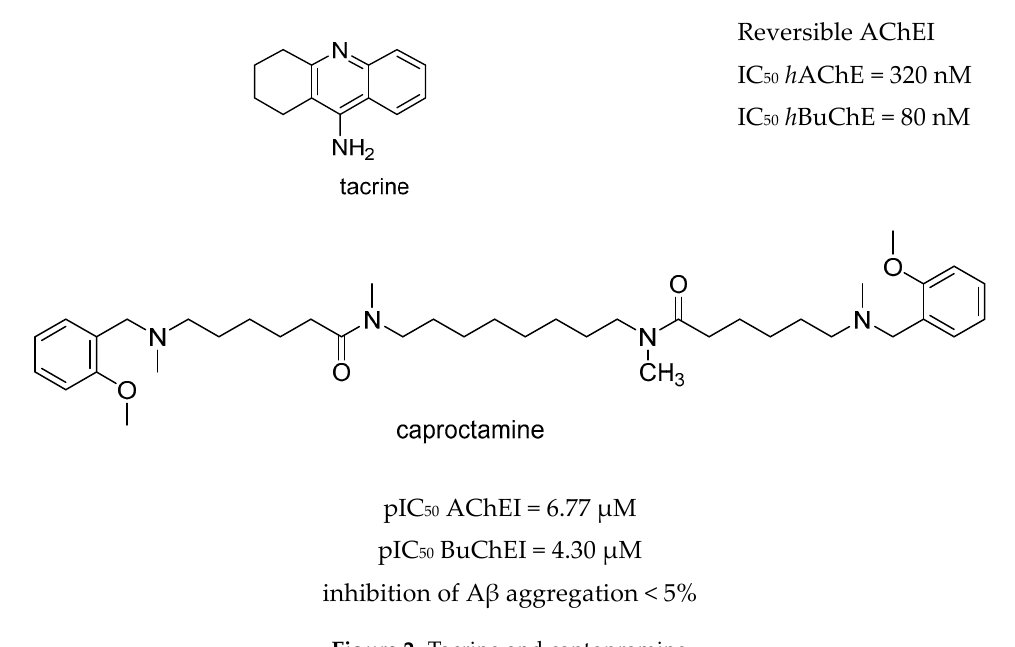
Figure 2. Tacrine and captopramine.